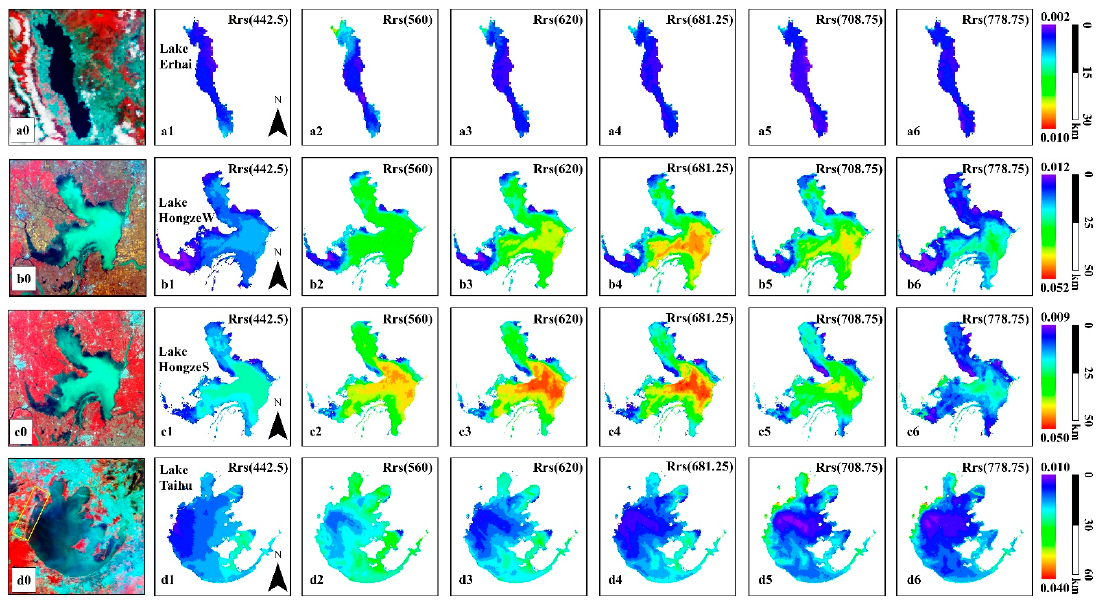
Figure 6. The false color atmospheric corrected images (R: OL17-865 nm, G: OL05-510 nm, B: OL02-412.5 nm) are presented at ( a0 – d0 ) using the same stretching method in the study areas. The atmospheric correction results by the ACbTC algorithm, i.e., Lake Erhai-20170419, Lake Hongze in winter (Lake HongzeW)-20161207, Lake Hongze in spring (Lake HongzeS)-20170518, and Lake Taihu-20170724, for which ( a1 – d1 ) R rs (442.5), ( a2 – d2 ) R rs (560), ( a3 – d3 ) R rs (620), ( a4 – d4 ) R rs (681.25), ( a5 – d5 ) R rs (708.75), and ( a6 – d6 ) R rs (778.75) in units of sr − 1 in the corresponding lakes. The highlighted yellow rectangle is masked to improve the interpretability of the R rs images from the western part to ZSB.